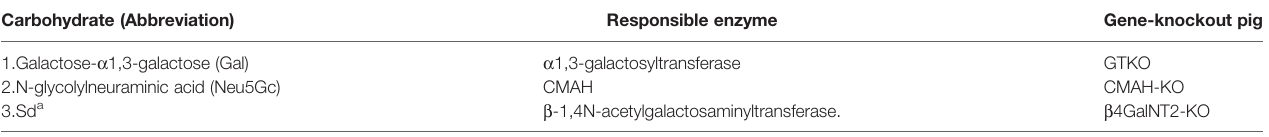
TABLE 4 | Known carbohydrate xenoantigens expressed on pig cells.